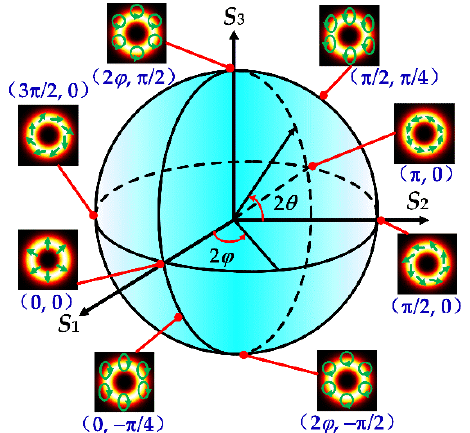
Here, φ = arg ( x + iy ) is the azimuthal angle, and l is order of the topological charge.